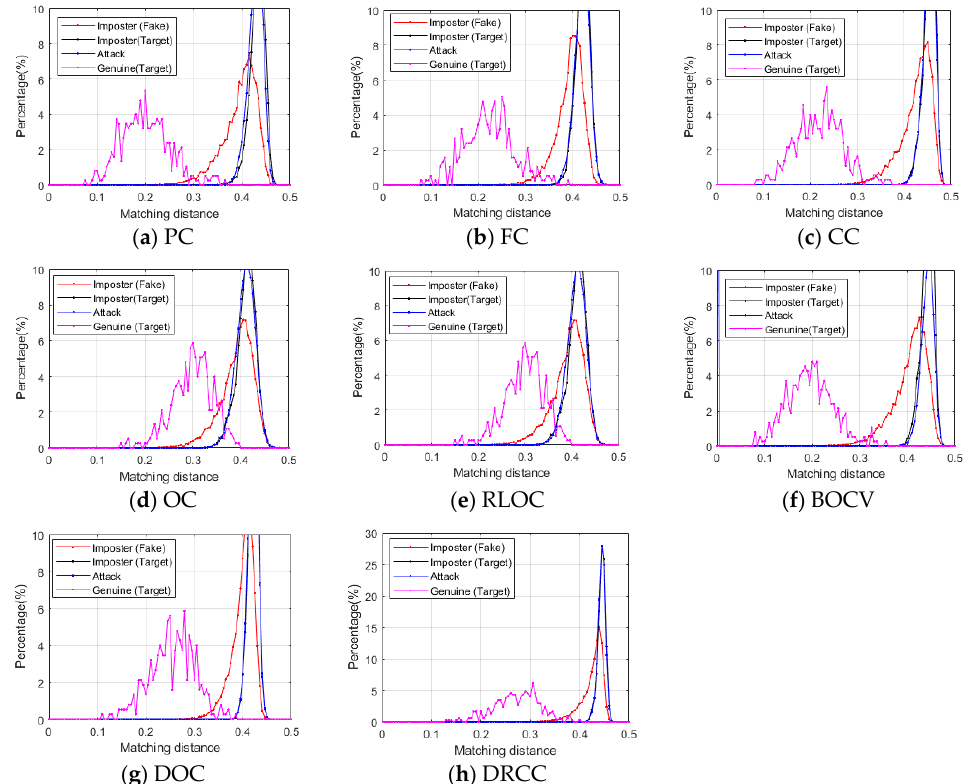
Table 4. Four distance distributions.